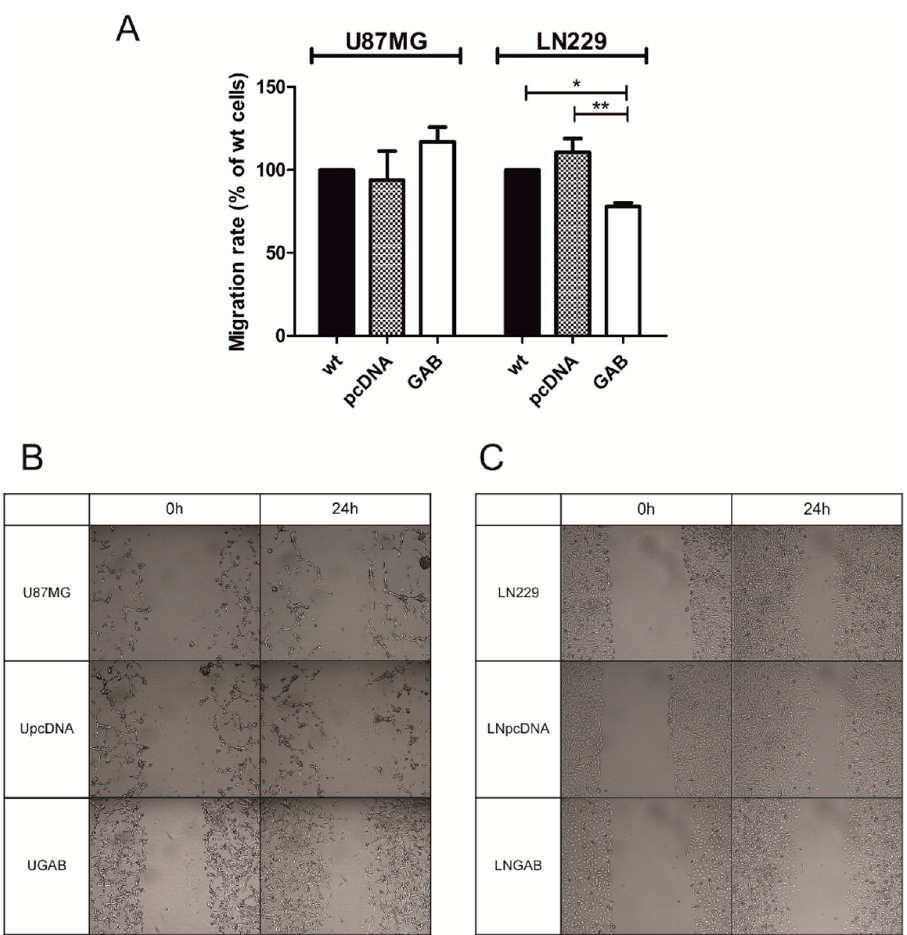
Figure 3. The influence of the transfection with the GAB sequence on the migration ability of U87MG and LN229 cells. ( A ) The migration rate of wt cells or cells stably transfected with the indicated plasmids was measured by the wound-healing. Twenty-four hours after seeding, the confluent cells were scratch-wounded with a micropipette tip. Wound borders were recorded and measured at 0 h and 24 h post-scratching. Results are mean ± SD ( n = 4–5) expressed as a percentage of the scratch gap observed for wt cells. * p < 0.05, ** p < 0.01 versus wt and pcDNA cells (one-way ANOVA followed by Tukey’s test). ( B , C ) Representative images of the scratch gaps taken at 0 h and 24 h after scratching. Magnification: objective 4× and digital 10×.